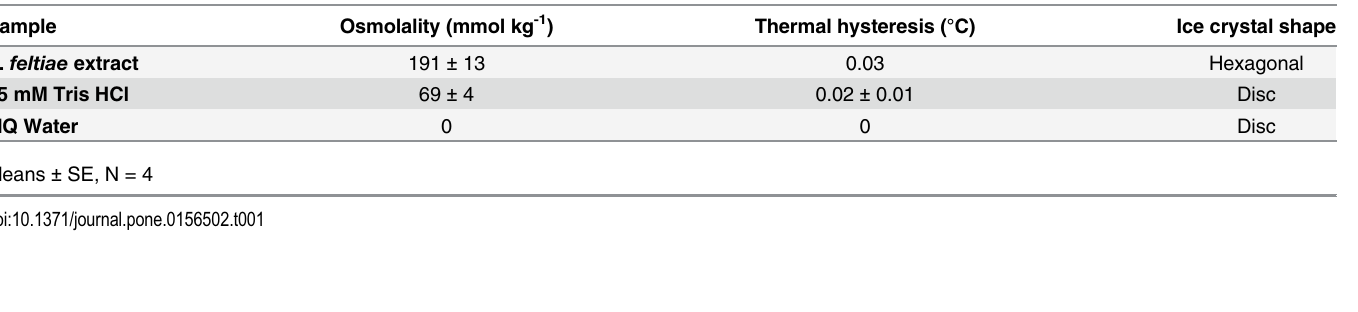
Table 1. Nanolitre osmometer measurements on Steinernema feltiae extract and